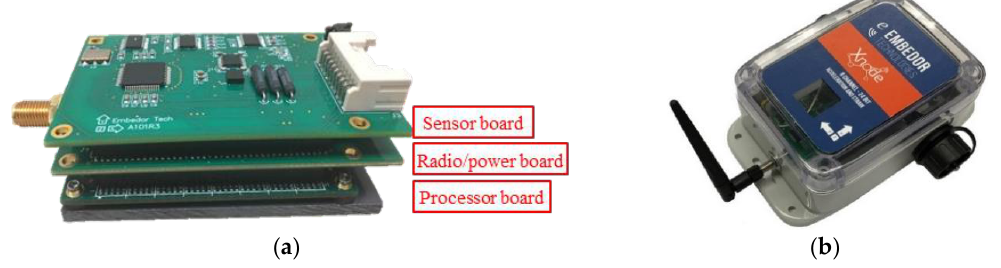
Figure 2. Xnode: ( a ) stacked modular boards; ( b ) weather-proof enclosure [34].